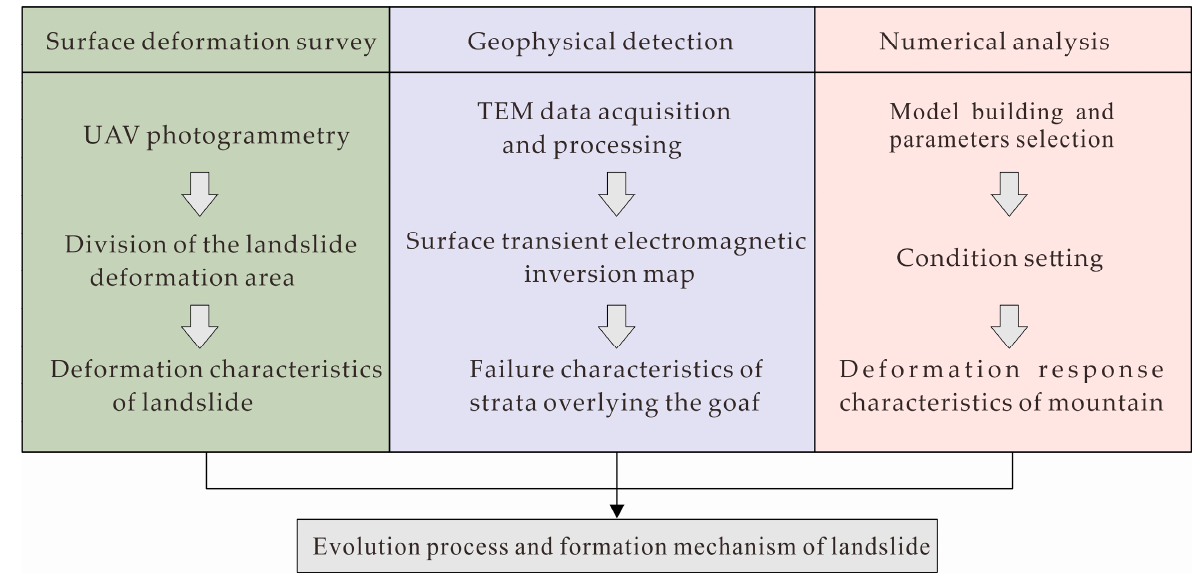
Figure 5. Flowchart dealing with the methodology.